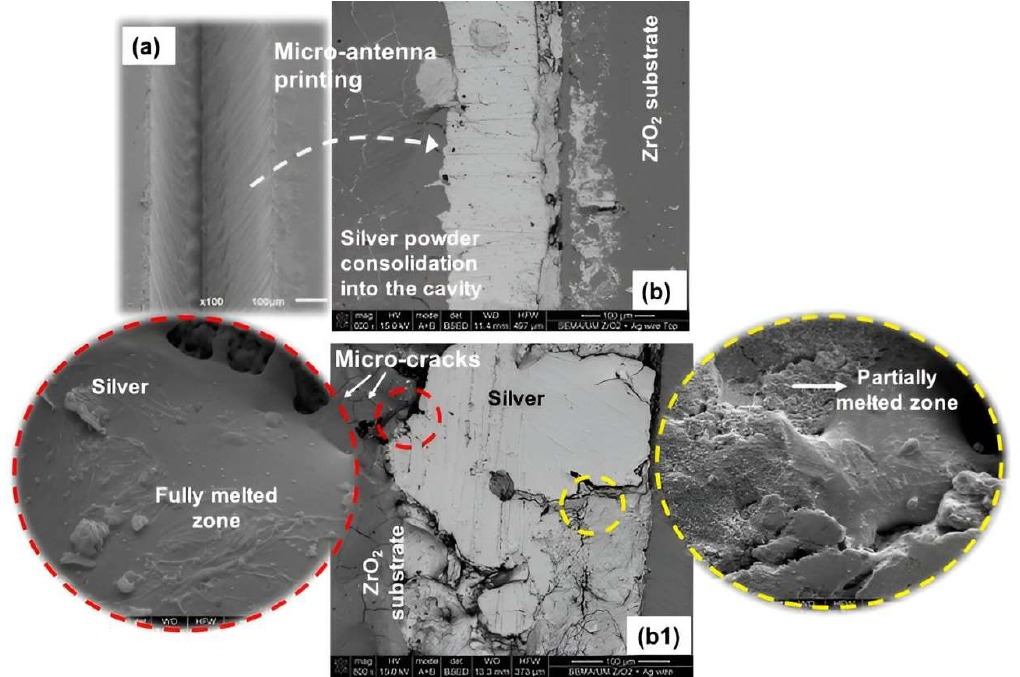
Figure 7. SEM micrographs of ( a ) Micro-cavity before the silver-based antenna printing, obtained after laser machining; ( b , b1 ) Micro-antenna printed into the cavity through laser sintering process, 800×.